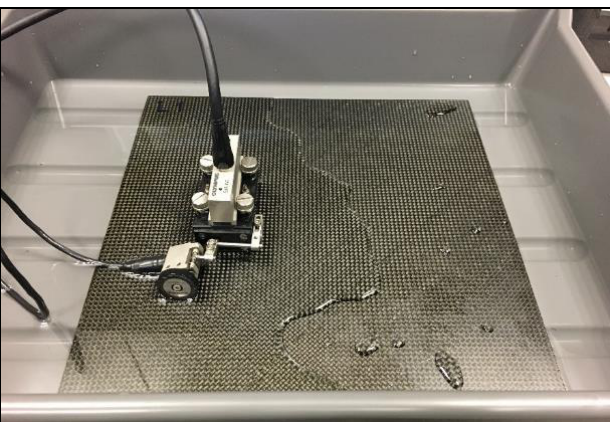
Figure 5. View of the immersion method.